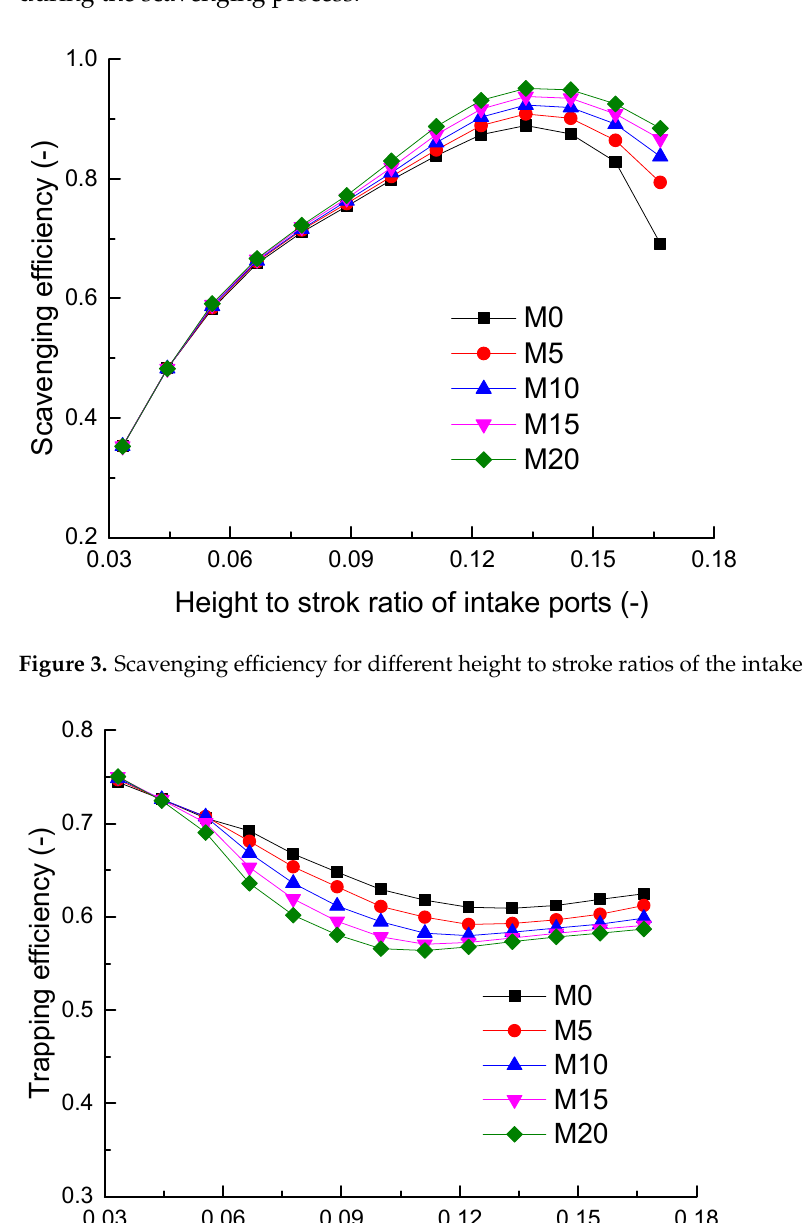
Figure 3. Scavenging efficiency for different height to stroke ratios of the intake ports.